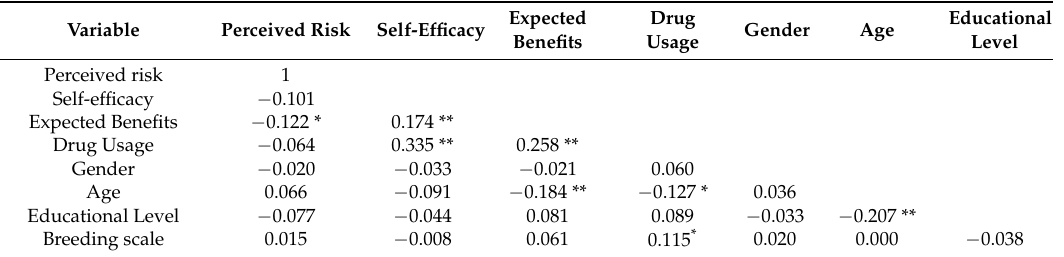
Table 4. Descriptive statistics.